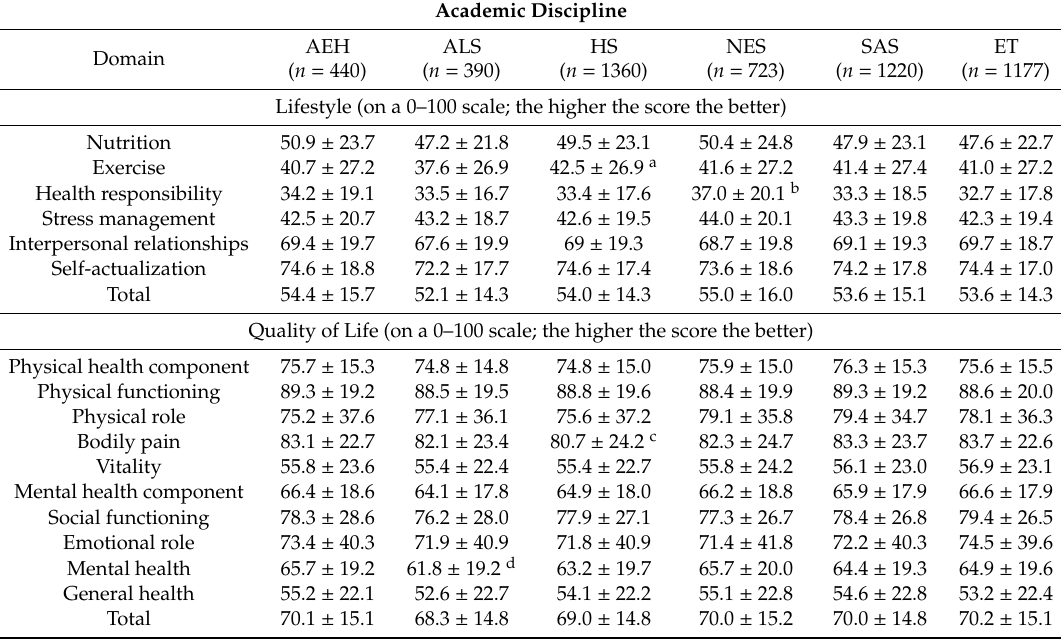
Table 2. Lifestyle and Quality of Life in University Students, Stratified by Academic Discipline ( N = 5443).